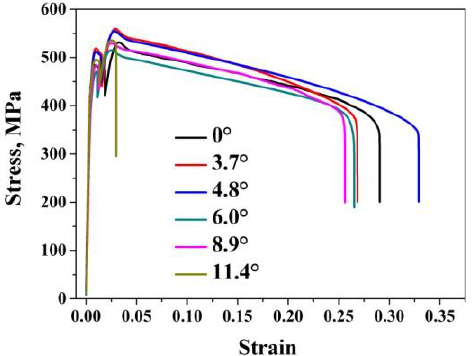
Figure 5. Tensile stress – strain curves of DD9 alloy with LABs at 1100°C.